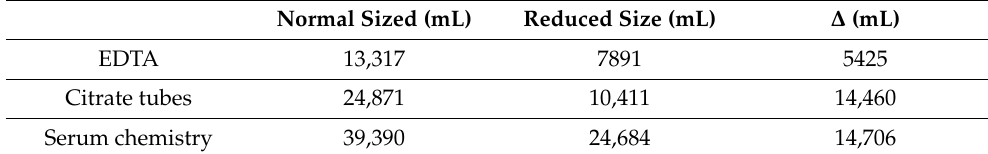
Figure 4. EDTA, citrate tubes, and serum chemistry with standard volume and reduced blood volume. Table 4. Effect of pediatric sized tubes in a 12-bed surgical ICU.